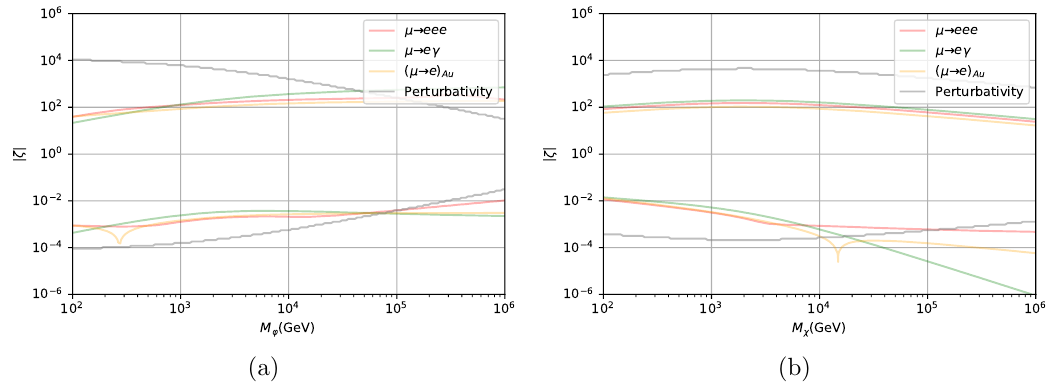
Figure 6. Regime 1 . Constraints on (cid:16) for varied isotriplet ’ LQ mass (a), and vector-like quark mass (b); in each case the alternate mass is (cid:12)xed at 2 TeV and the isosinglet LQ couplings are switched o(cid:11). Allowed points for each constraint lie between the two same-coloured lines. The ‘dip’ in both graphs is due to an accidental cancellation by virtue of parameter choice.